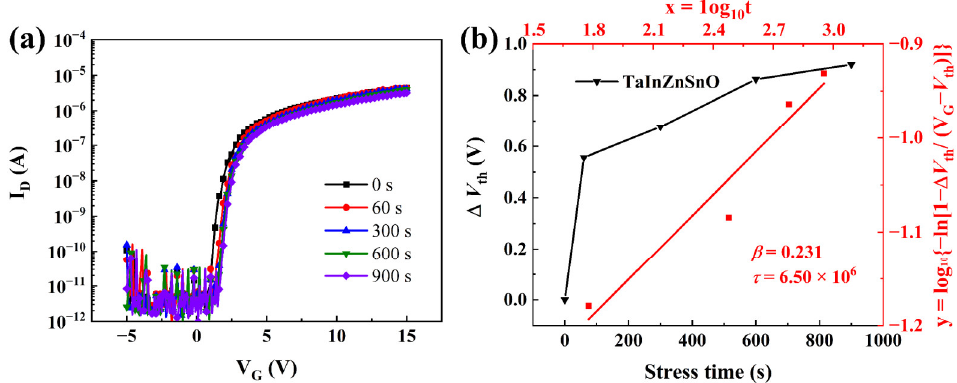
Figure 7. ( a ) PBS of TaInZnSnO TFTs. ( b ) The dependence of ∆ V th on stress time and the fitted curves described by Equation (7) for the TaInZnSnO TFT.